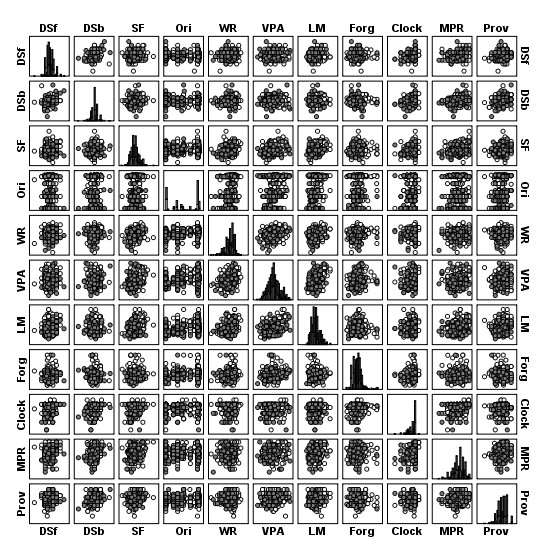
Scatter biplots for MCI (white circles) and Dementia (black circles) patients in the 11 predictors and its histograms (DSf - Digit Span Forward; DSb - Digit Span Backward; SF - Verbal Semantic Fluency; Ori - Orientation; WR - Word Recall; VPA - Verbal Paired-associate Learning; LM - Logical Memory; Forg - Forgetting Index; Clock-Clock Drawing; MPR - Raven Progressive Matrices; Prov - Interpretation of Proverbs). See text for tests descriptions.